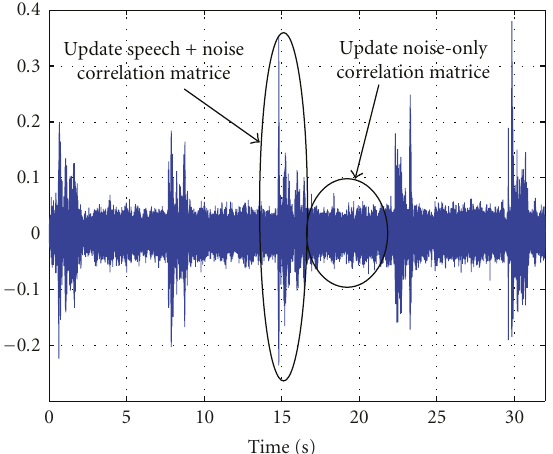
Figure 2: Illustration of a concatenated noisy speech signal with noise-only periods which is a typical input signal for multimicro- phone noise